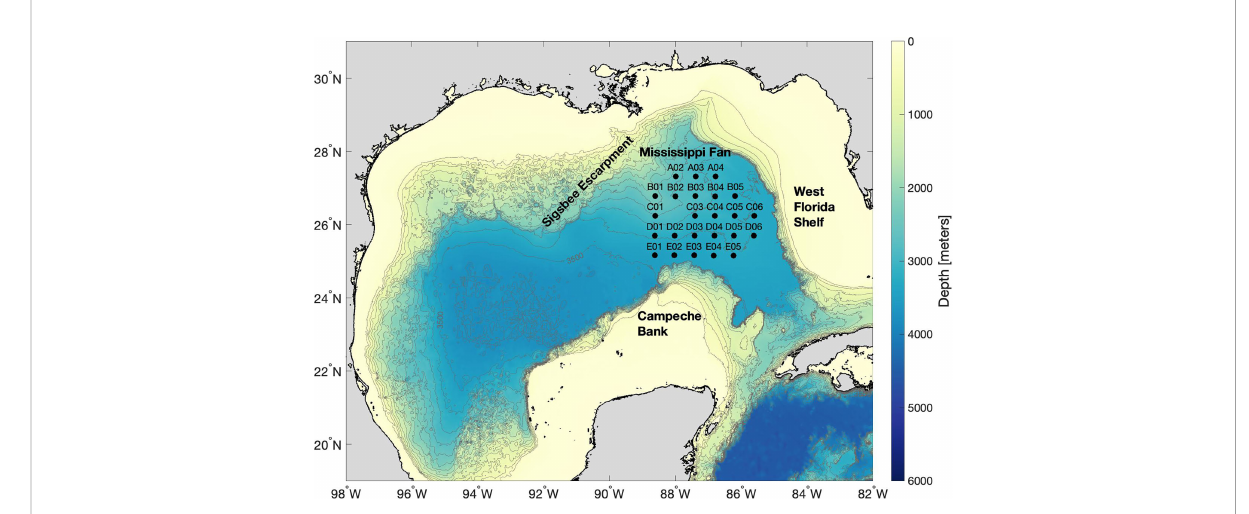
FIGURE 1 The Understanding Gulf Ocean Systems array comprised of 24 CPIES deployed June 2019 and recovered May 2021 in the eastern Gulf of Mexico. Locations of the CPIES are denoted by black circles and labeled. Bathymetry is contoured every 250